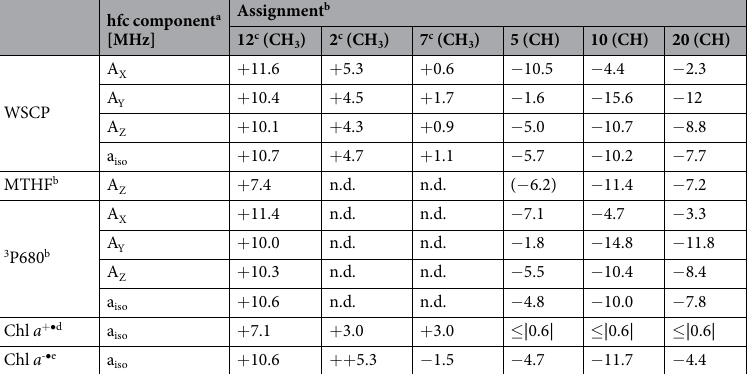
Table 2. hfcs of 3 Chl a protons from the Davies and Mims ENDOR spectra shown in Fig. 3A. a Principal components of the hfc tensor, axes collinear with the ZFS axes (X, Y, Z) within 20°. b Based on Lendzian et al . 49 . c Magnetically equivalent protons of the methyl group. d Based on Huber et al . 53 . e Based on Hoff et al . 54